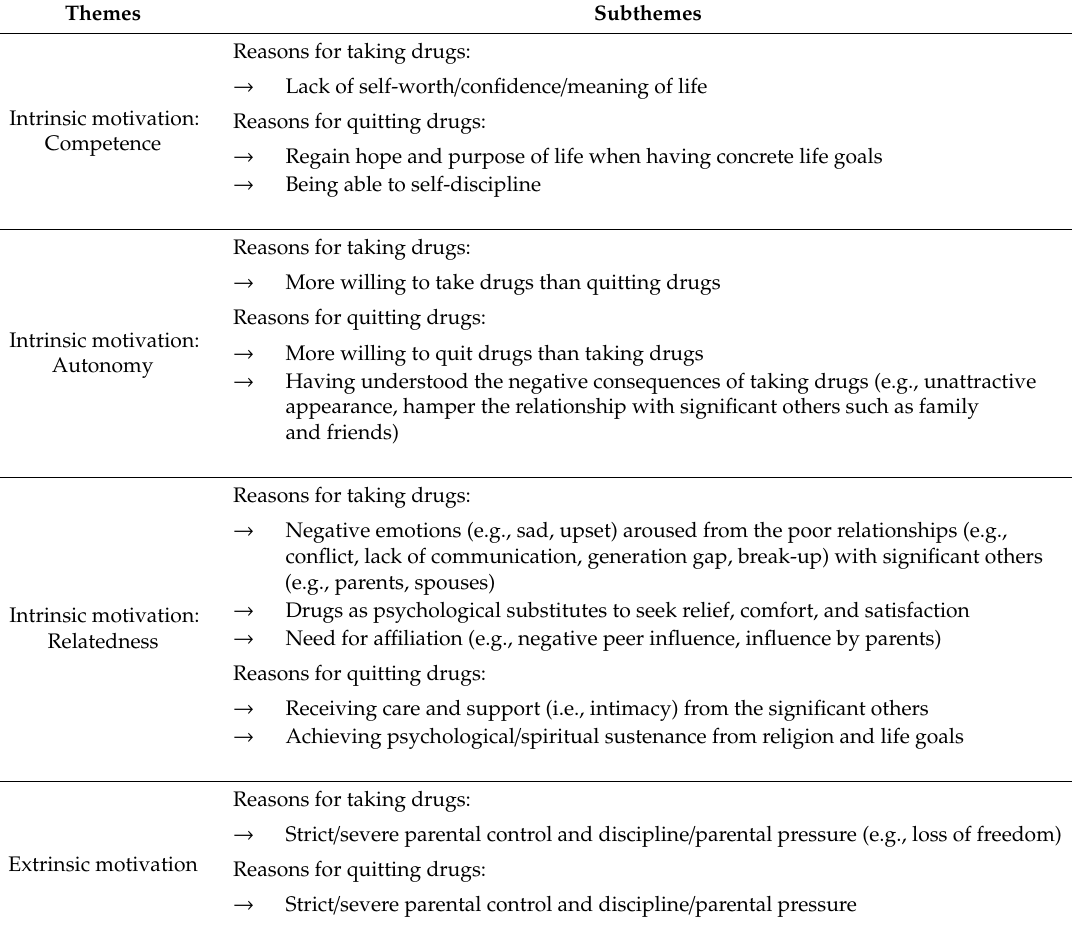
Table 3. Coding structure of narratives of DATC